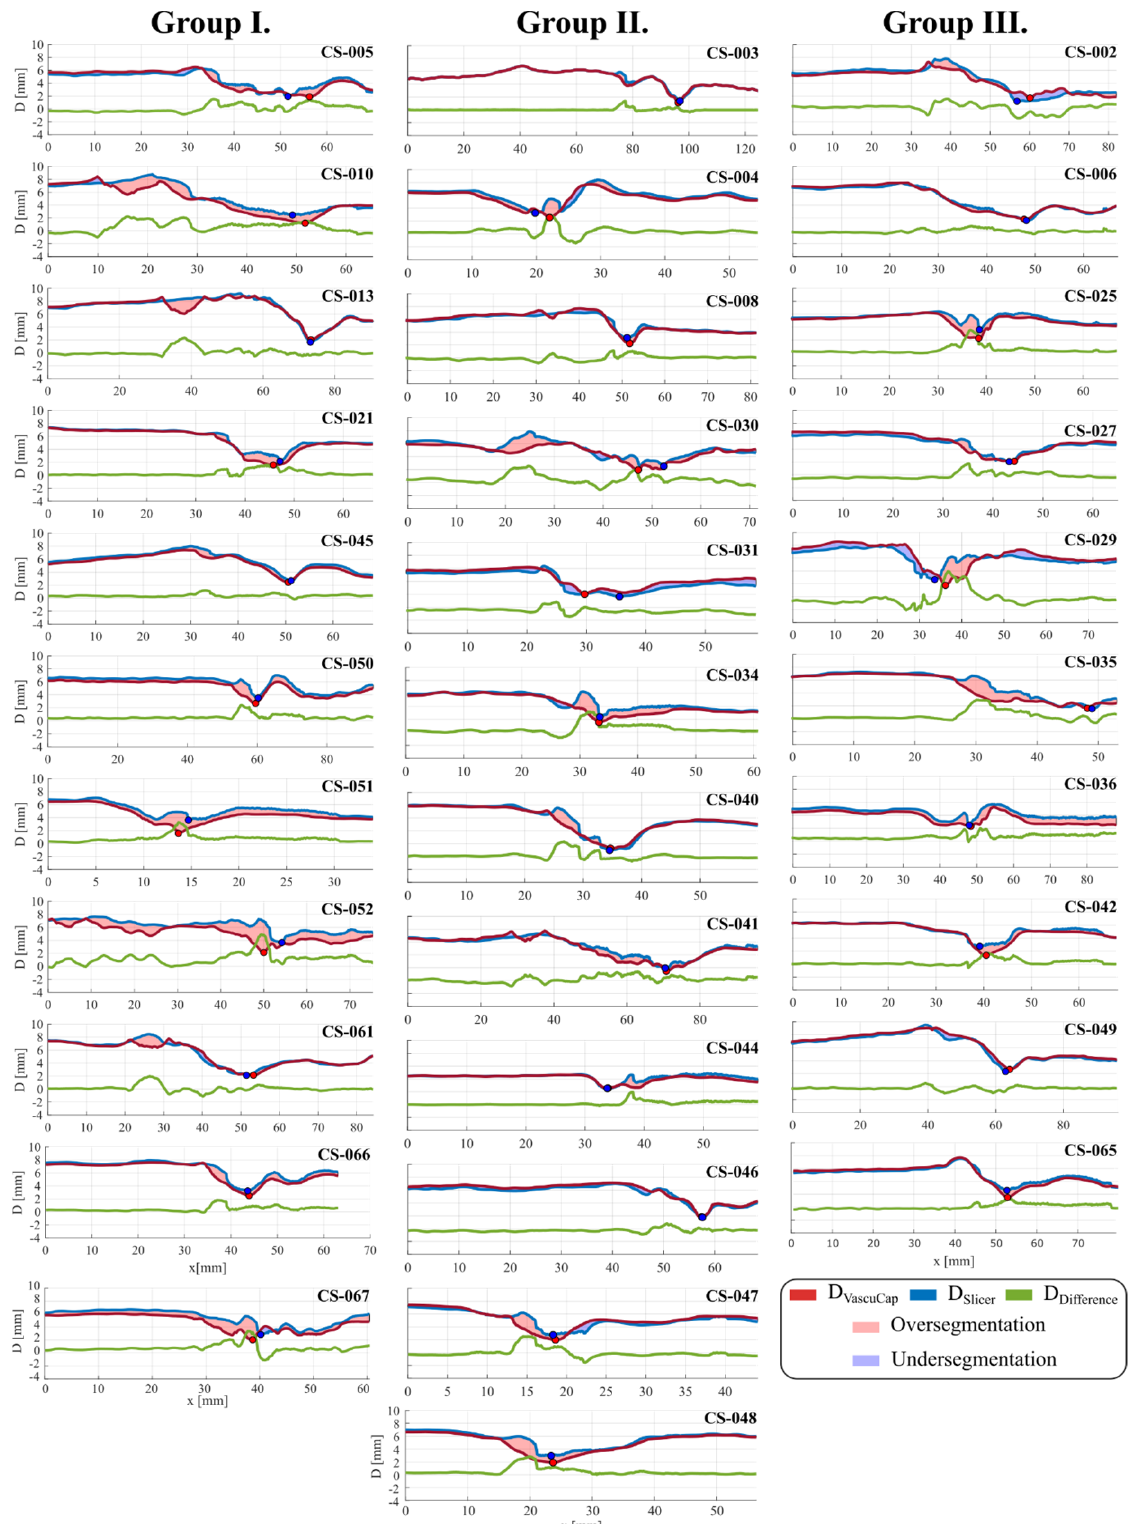
Figure 3. All evaluated cases as described in Figure 2.